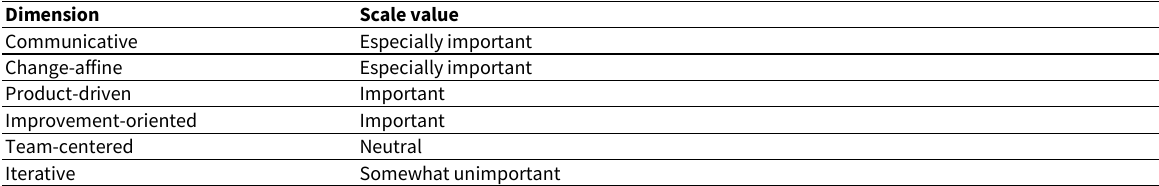
Table 2. Preset of the weighting questions